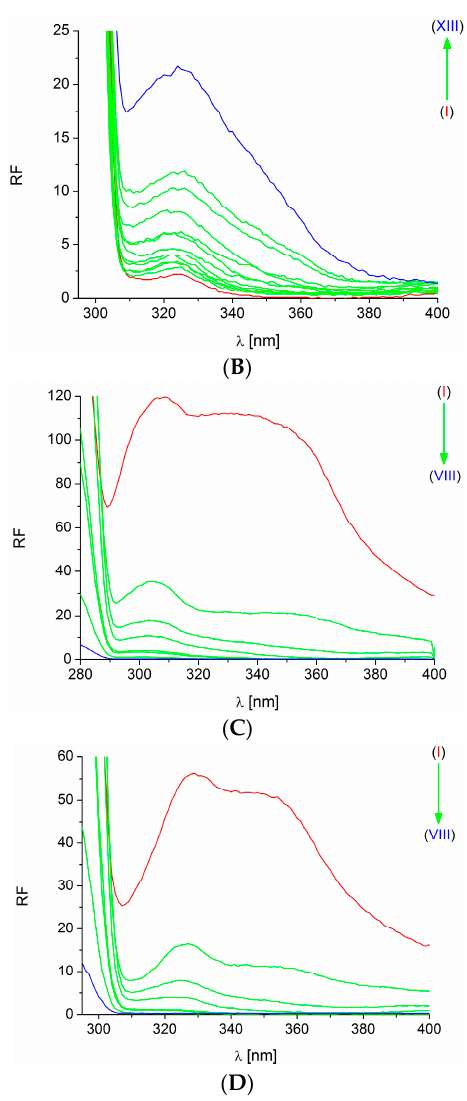
Figure 3. The increase of PpIX (I, 5 × 10 − 5 M) fluorescence excited at λ ex = 280 nm ( A ) and 295 nm ( B ) in the presence of HSA (II, 2 × 10 − 7 M; III, 3 × 10 − 7 M; IV, 4 × 10 − 7 M; V, 5 × 10 − 7 M; VI, 7.5 × 10 − 7 M; VII, 1 × 10 − 6 M; VIII, 1.25 × 10 − 6 M; IX, 2 × 10 − 6 M; X, 2.5 × 10 − 6 M; XI, 4 × 10 − 6 M; XII, 5 × 10 − 6 M; XIII, 9 × 10 − 6 M). Quenching of HSA (I, 7.5 × 10 − 7 M) fluorescence excited at λ ex = 280 nm ( C ) and 295 nm ( D ) in the presence of PpIX (II, 1 × 10 − 5 M; III, 3 × 10 − 5 M; IV, 5 × 10 − 5 M; V, 9 × 10 − 5 M; VI, 1 × 10 − 4 M; VII, 1.5 × 10 − 4 M; VIII, 3 × 10 − 4 M).